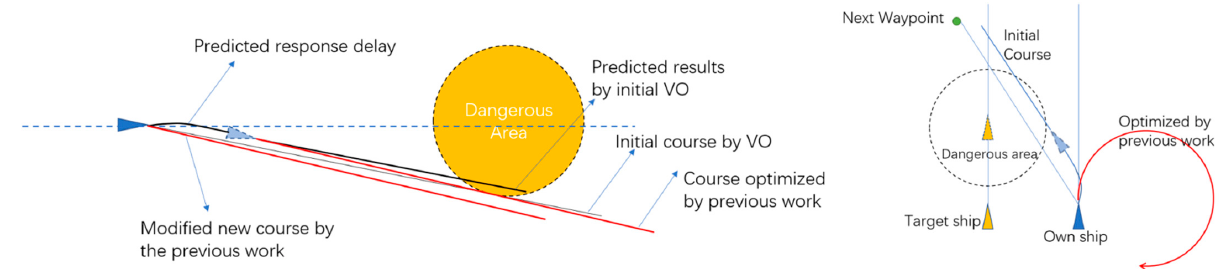
Figure 14. The main contributions of the previous work [15], delay reducing ( left part ) and parallel unlocking ( right part ). The figure is adapted with permission from Ref. [15]. 2022, Zhengyu Zhou.